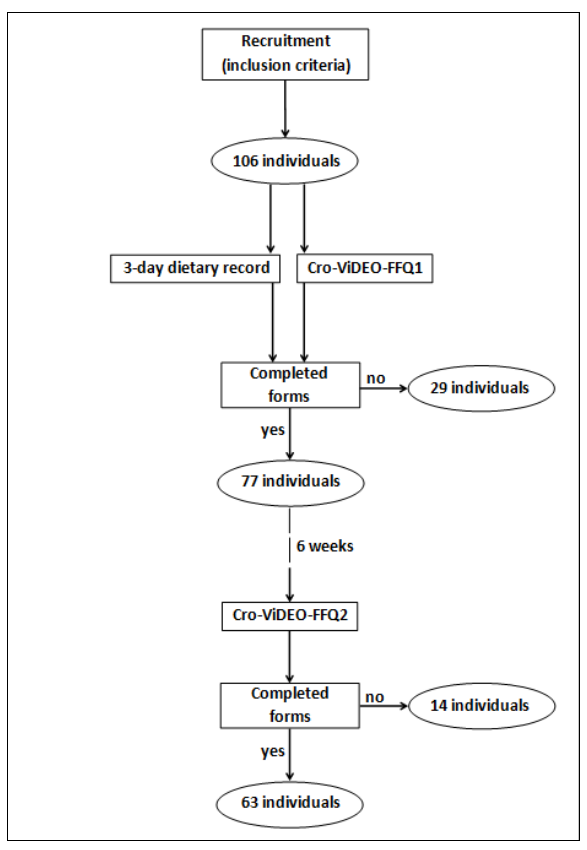
Figure 1. Study design and number of participants.